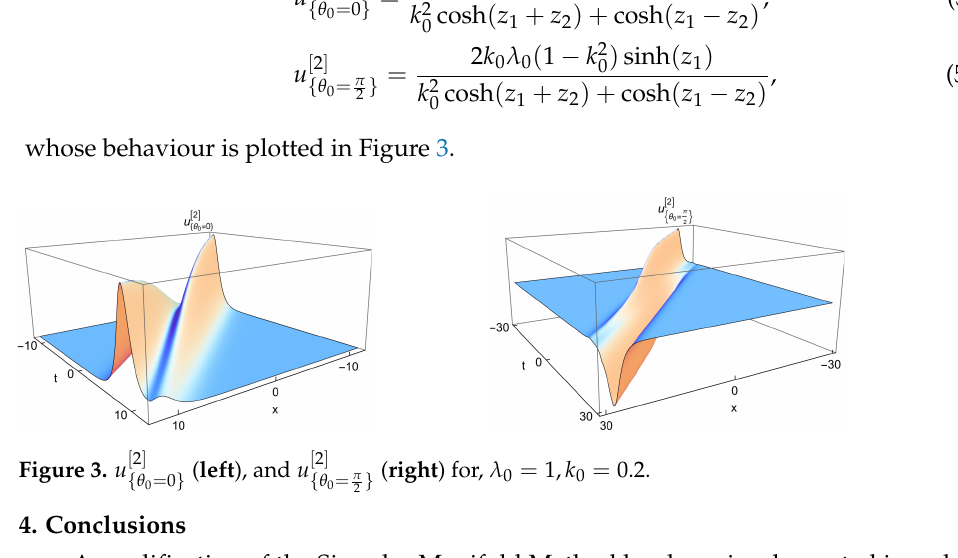
[ 2 ] ( right ) for, λ 0 = 1, k 0 = } { θ 0 = π 2